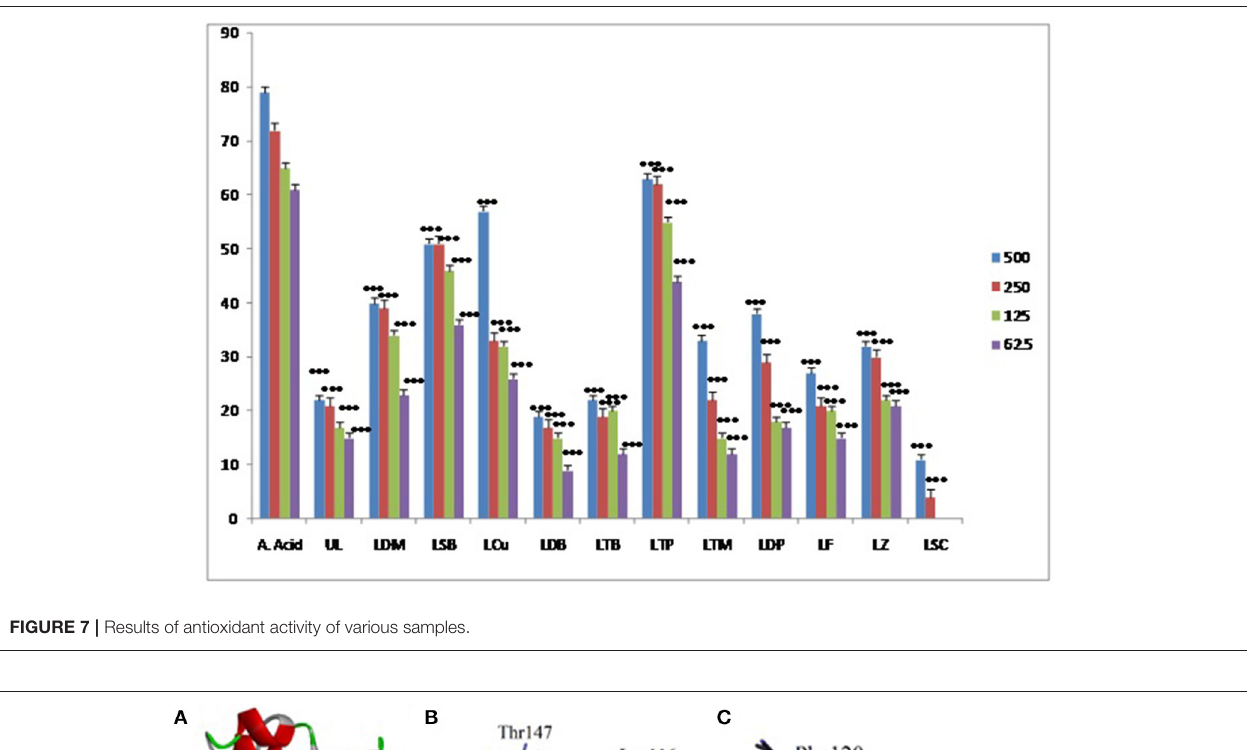
FIGURE 7 | Results of antioxidant activity of various samples.